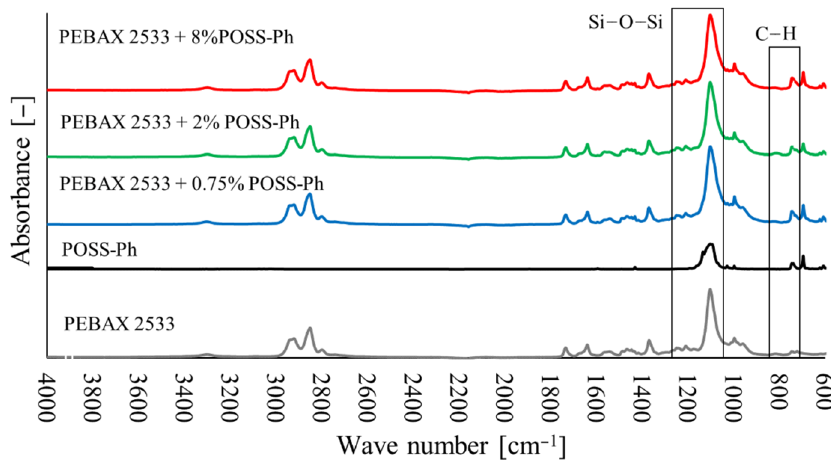
Figure 11. FTIR analysis of membranes containing SiO 2 in different concentrations.